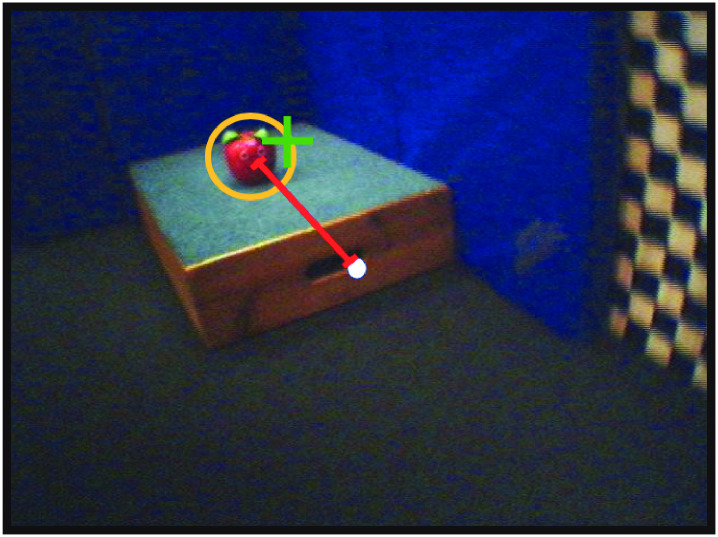
Looking episode and centering.A frame was defined as a looking episode when eye gaze (green cross) fell on or within ROI (yellow ellipse). Centering (red line) was the distance of toy location to the center of the field of view (white dot).